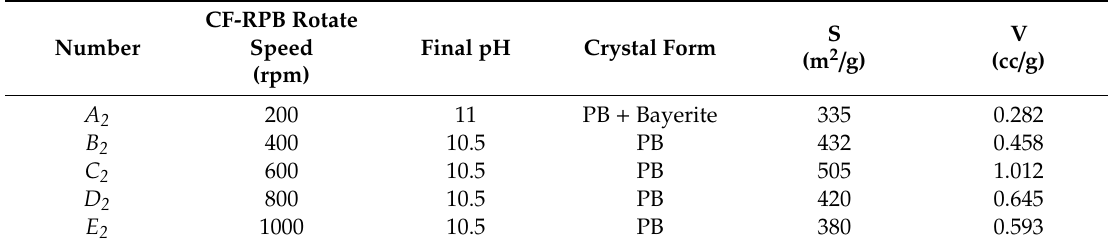
Table 4. E ff ect of the rotating speed of CF-RPB on pore properties of PB (concentration of NaAlO 2 solution, 0.1 mol / L; gas–liquid ratio,